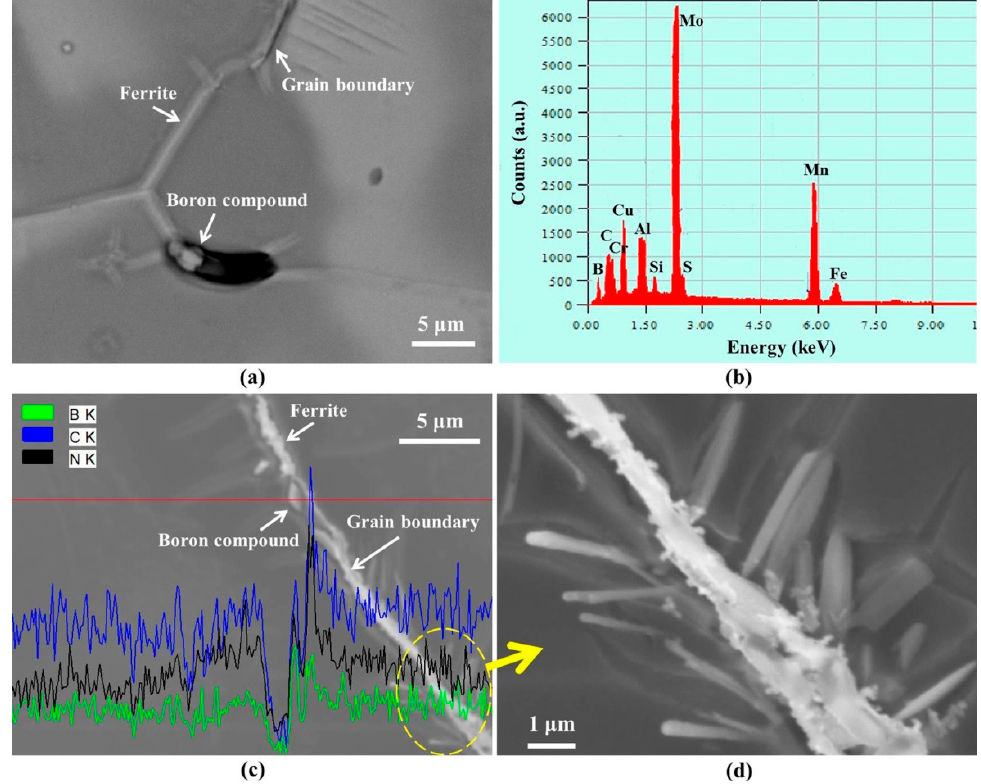
Figure 9. Boron compounds identified in the dendritic microstructure and located at grain boundaries: ( a ) SEM micrograph of TW-B1, ( b ) elemental SEM–EDX analysis of particle in TW-B1, ( c ) SEM micrograph of TW-B2 showing an over layer line scan, and ( d ) grain boundary SEM micrograph magnification in TW-B2.